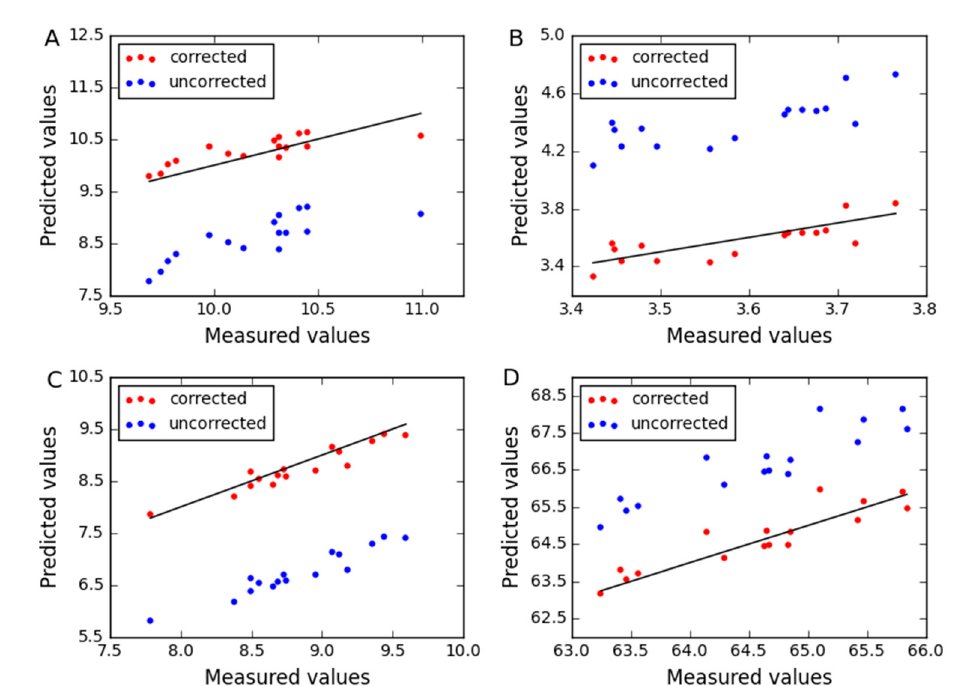
Figure 2. The relationship between the uncorrected and the corrected predict values for corn dataset by ( A ) moisture, ( B ) oil, ( C ) protein and ( D ) starch. The blue and red dots represent the uncorrected and the corrected predicted results for each sample, respectively. Table 2. Summary of the relevant results between uncorrected and CTAI corrected.